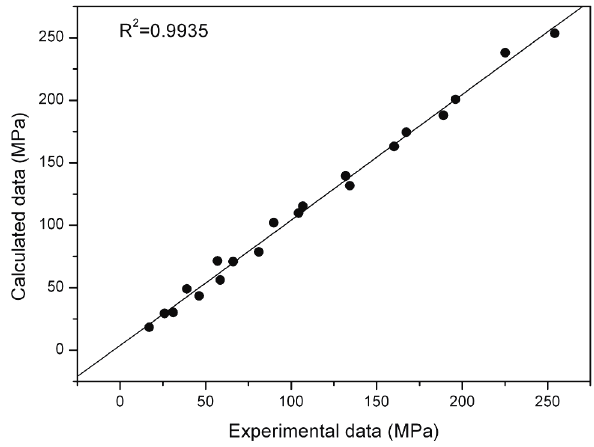
Fig. 5: Comparison between the peak stress of calculated and experimental data